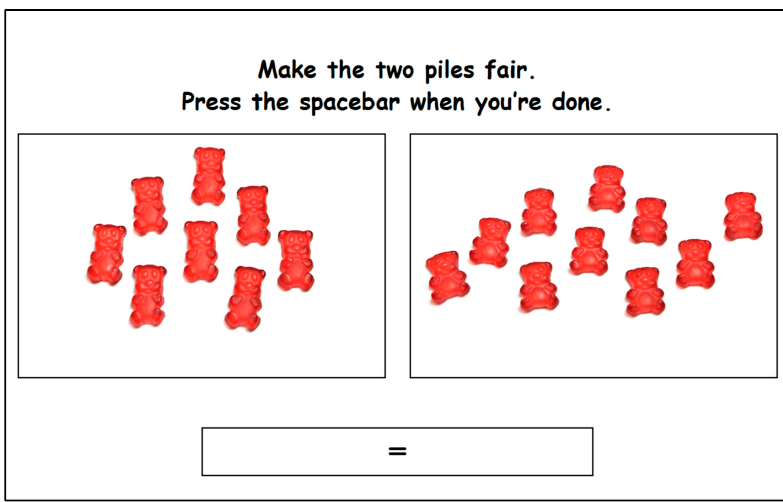
Figure 3. Screen capture of the matching task in which eight TALLER gummy candies are presented on the left (“test”) pile, and 10 REFERENCE gummy candies were selected by the child on the right pile. The sign ‘=’ was used to remind the children to make two fair piles of candies.